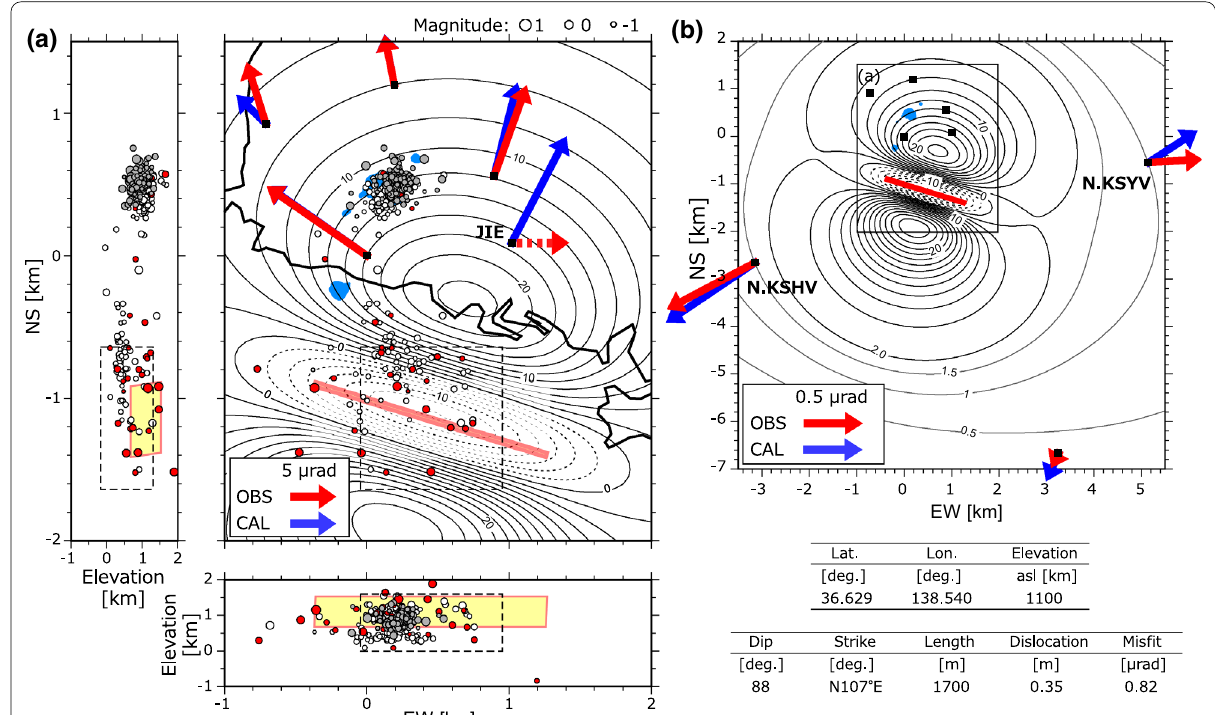
Fig. 5 Comparison of observed (red arrows) and modeled (blue arrows) tilt vectors of phase 1 (Fig. 3). The location of the modeled crack is represented by the yellow rectangle. Modeled vertical displacement is projected onto a virtual plane at 2100 m asl (corresponding to an altitude of MC) at intervals of 5 mm. Solid and dashed contour lines correspond to vertical uplift and subsidence, respectively. White, red, and gray circles represent hypocenters determined by the KSVO for the periods from 1 January 2016 to 22 January 2018 (before the eruption), from 23 January to 22 April 2018 (after the eruption), and from 22 to 23 April 2018 (representative of SPCG unrest in 2018), respectively. Optimal crack parameters are summarized in the lower right of the figure. The square with the dashed line represents the area shown in Fig.